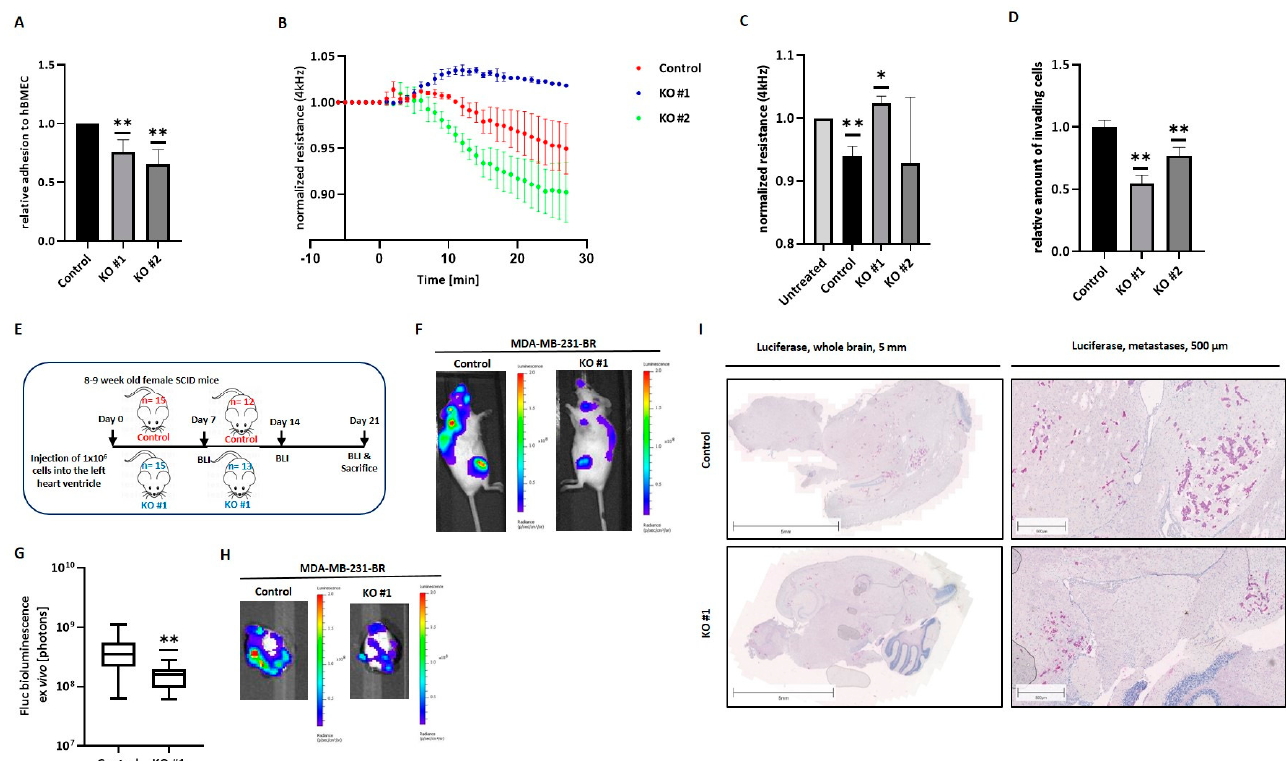
Figure 5. Effect of HYAL1 KO on the interaction between MDA-MB-231-BR cells and the brain endothelium in vitro and BM formation in vivo. ( A ) Tumor cell (MDA-MB-231-BR control, HYAL1 KO #1, HYAL1 KO #2) adhesion to primary human brain endothelial cells (hBMECs) was analyzed under static conditions. The relative amount (to control cells =1) of adhesive cells is shown ( n = 5). ( B ) Electrical cell–substrate impedance sensing (ECIS): normalized resistance at 4 kHz (values were set as 1 prior treatment; representative experiment; n = 3). ( C ) Bar graphs displaying relative resistance values at 4 kHz under the influence of different tumor cells ( n = 3). ( D ) Invasion potential of tumor cells (MDA-MB-231-BR control, HYAL1 KO #1, HYAL1 KO #2) through a brain endothelial cell monolayer measured by the Transwell assay ( n = 3). ( E ) Schematic representation of the animal study design. A total of 15 mice/group were injected. ( F ) Representative biolumi- nescence images (BLI) of whole mice corresponding to each group (MDA-MB-231-BR control: n = 12, HYAL1 KO #1: n = 13) 21 days after injection. ( G ) Ex vivo BLI signals from brains of both groups (MDA-MB-231-BR control: n = 12, HYAL1 KO #1: n = 13). ( H ) Representative pictures of BLI-measured brains (MDA-MB-231-BR control: n = 12, HYAL1 KO #1: n = 13) at the final time point (21 days after injection). ( I ) Immunohistochemical staining of brain tissue Luciferase (MDA-MB- 231-BR control: n = 12, HYAL1 KO #1: n = 13). Corresponding scales are indicated above the pictures. Statistical significance was determined using unpaired two-tailed Student´s t-tests. The assumption of homogeneity of variance was tested using Levene´s Test of Equality of Variances ( p > 0.05). Values are means +/ − s.d. * p < 0.05, ** p <